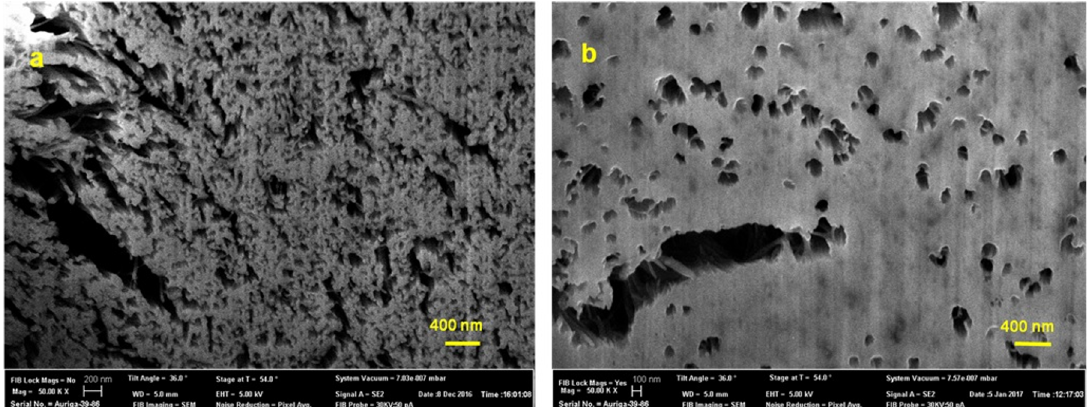
Figure 6. SEM images of a CNT yarn irradiated with ebeam at 800 kGy (a) and CNT yarn gamma irradiated with at 100 kGy -cut using a focused ion beam (FIB).